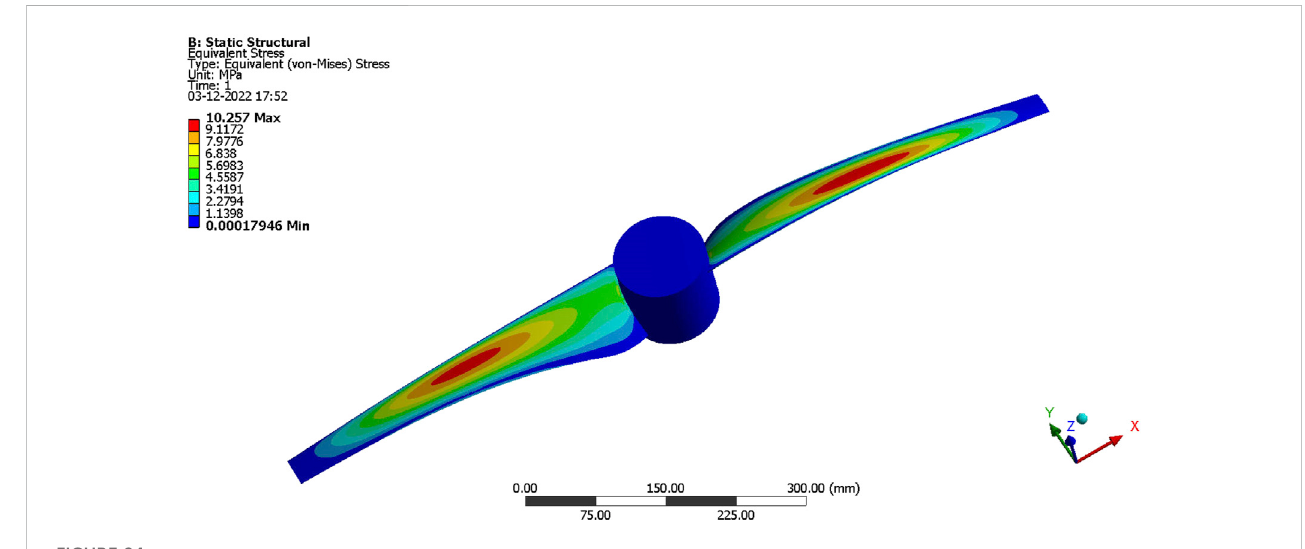
Equivalent stress – GFRP-FR-4-Woven.